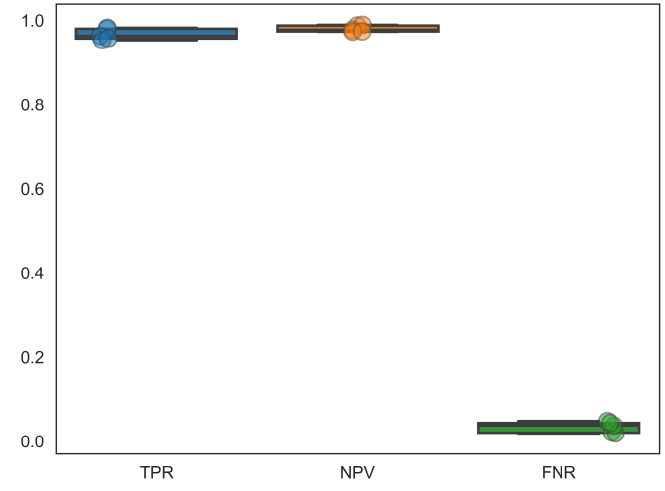
Figure 6. Performance metrics ( TPR , NPV , FNR ) to evaluate our model’s applicability in multitargets prediction. Different colors means different performance evaluation.